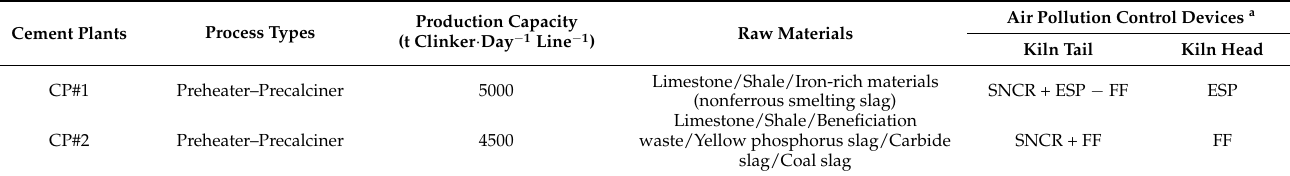
Table 1. Information about the studied